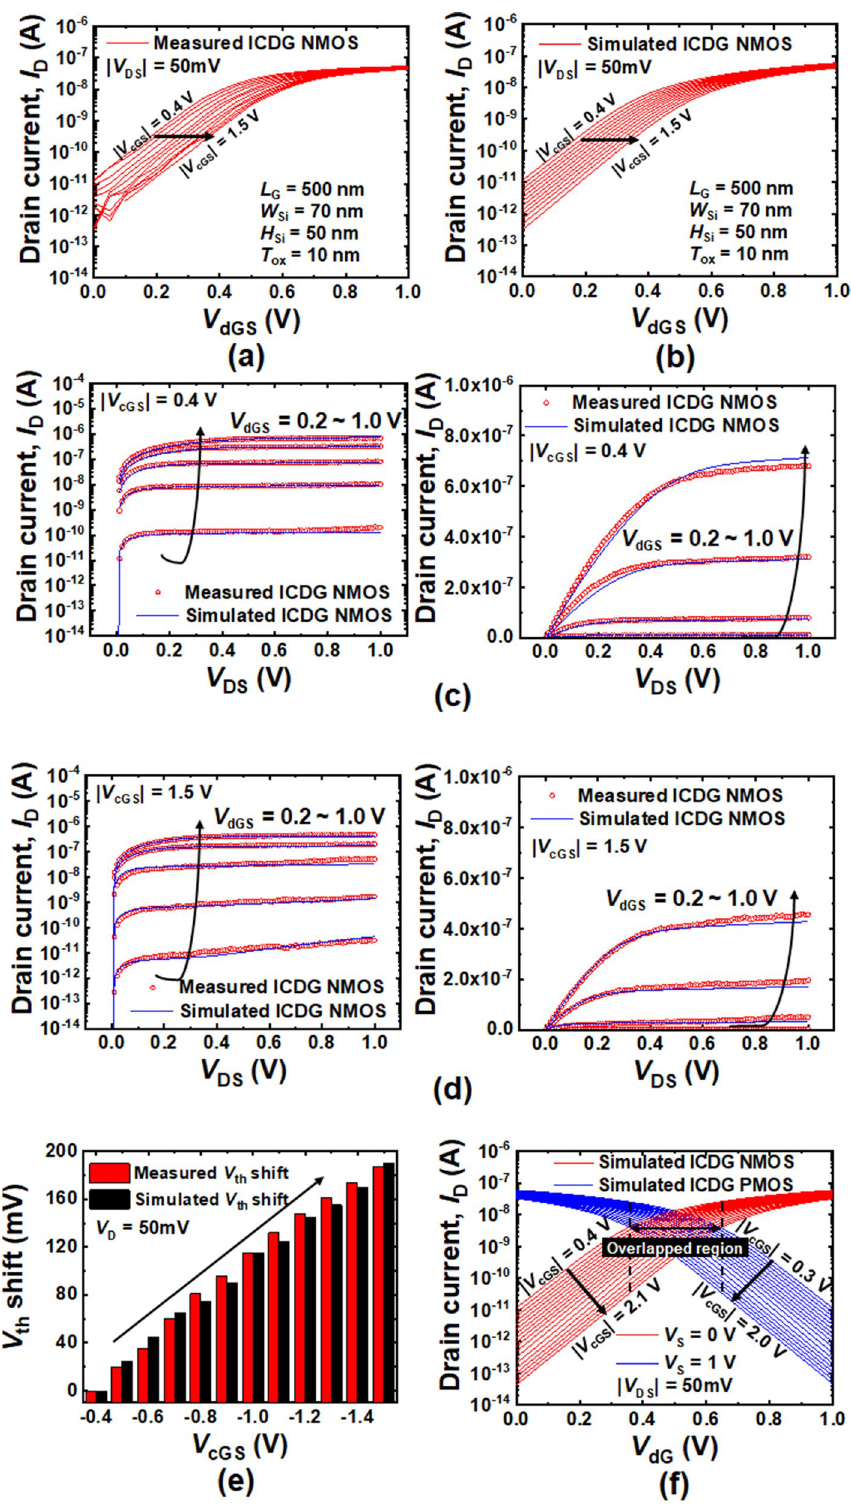
Figure 2. (a) Measured I D - V dGS characteristics from the fabricated ICDG NMOS for various | V cGS | . (b) Semi- empirically simulated I D - V dGS characteristics according to various | V cGS | . Superimposition of measured and simulated I D - V DS characteristics of N-channel for (c) | V cGS | = 0.4 V and (d) 1.5 V on the log-scaled y -axis and linear-scaled y -axis. (e) Linear V th shift by V cGS . (f) Simulated I D - V dGS characteristics of both ICDG NMOS and PMOS for various | V cGS |